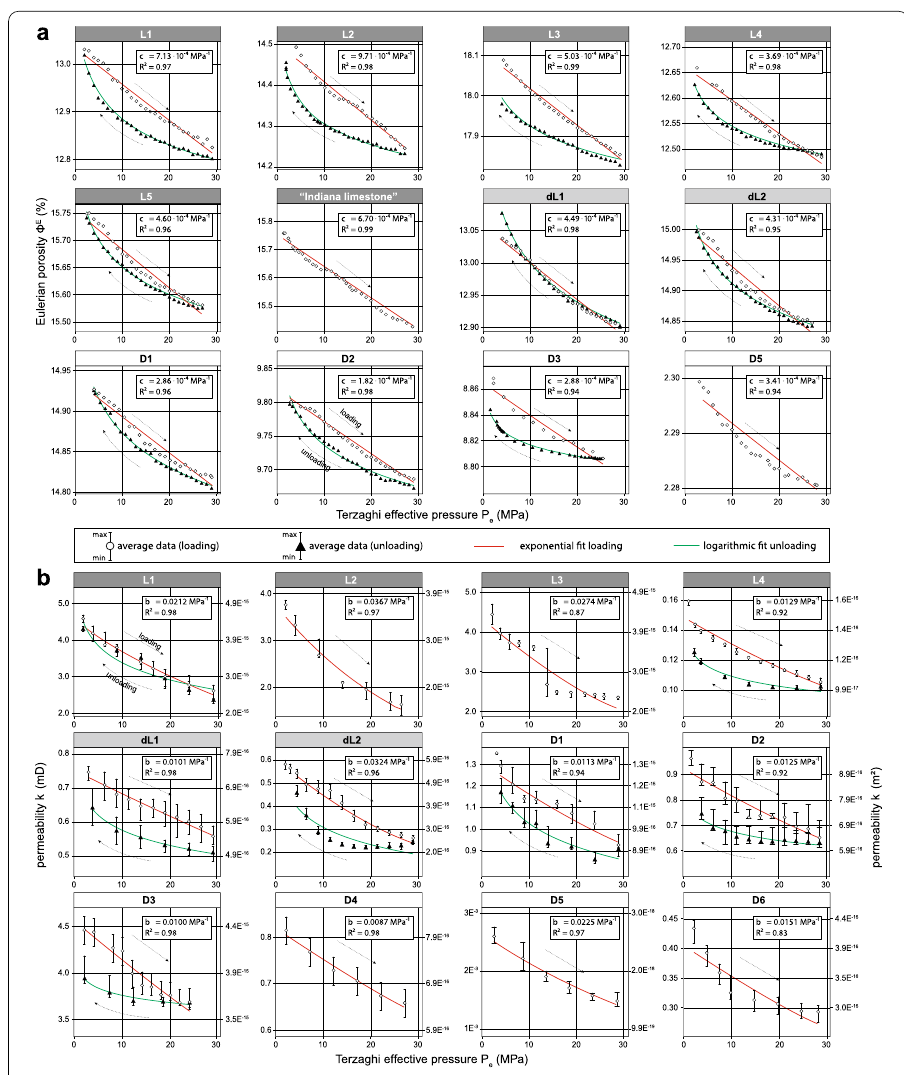
Fig. 10 Evolution of Eulerian porosity ( a ) and permeability ( b ) as a function of Terzaghi effective pressure in drained hydrostatic tests. Porosity was measured during a continuous compression test, while permeability was measured for each pressure level over an extended period of time—the error bars, therefore, represent a threshold for each pressure stage. During the loading phase, porosity and permeability decrease continuously as the effective pressure increases. The stress sensitivity coefficients c for porosity and b were determined by exponential regression. The unloading phase shows a relaxation hysteresis, an irreversible loss of pore volume, and a permanent loss of permeability (up to 20%) at the end of the test cycle. “Indiana limestone” data from Meng et al. (2019) were used to compare the results and show similar